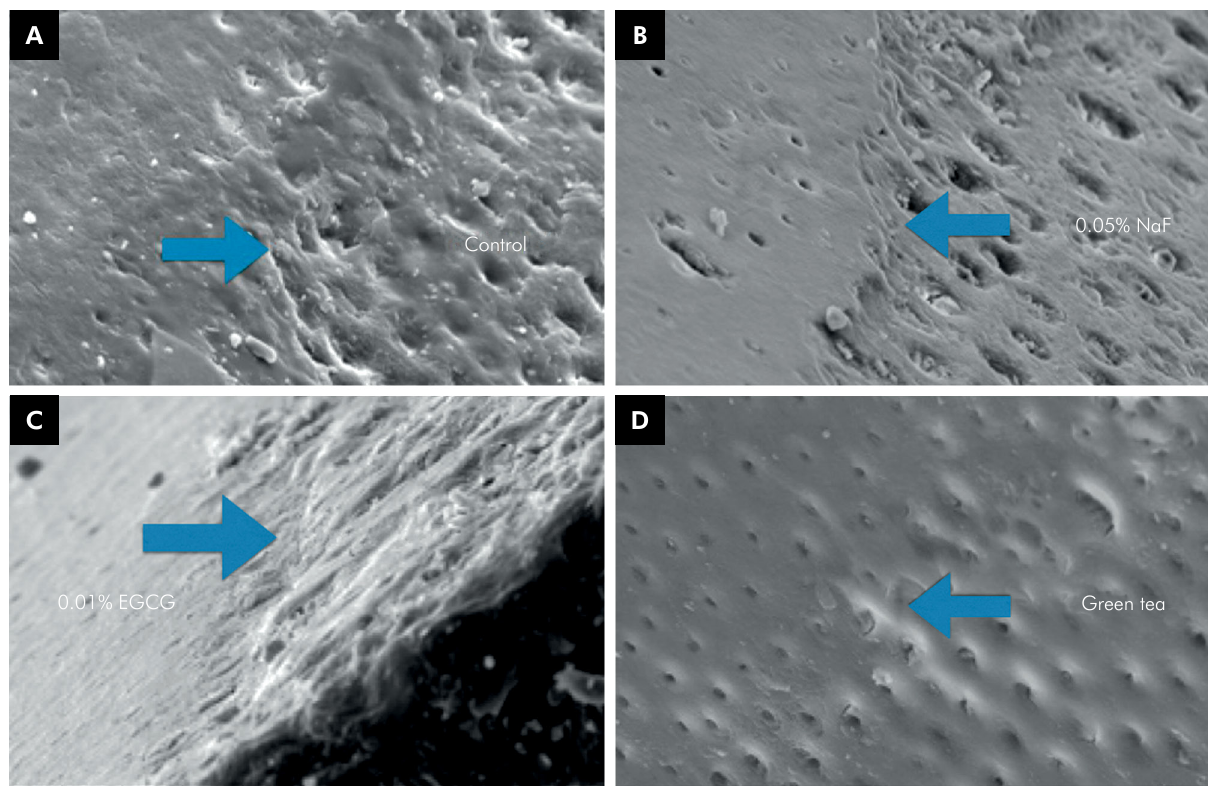
Figure 4. Representative scanning electron microscopy (SEM) (magnification 4000x) images of the interface between the reference (left) and eroded (right) area that were not treated (negative control) (A), or treated with NaF 0.05%(B); EGCG 0.1%(C); and Green tea solution (D). The arrow represents the interface between the reference and eroded